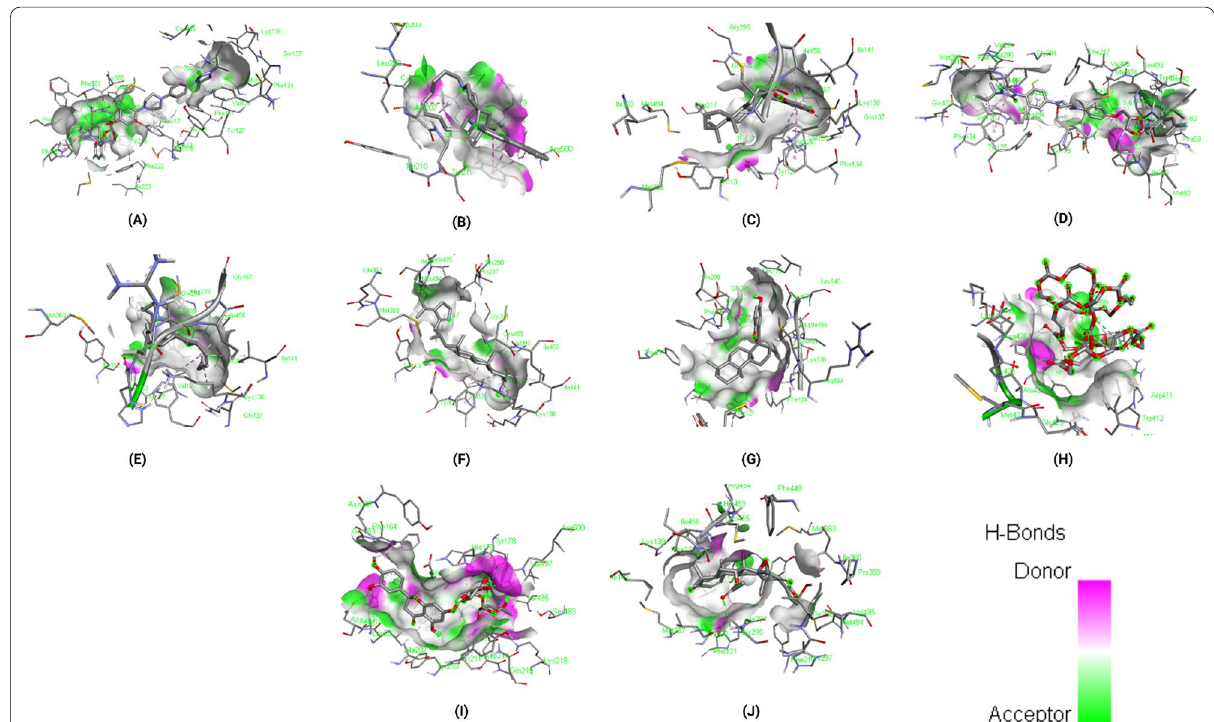
Fig. 7 3D visualisation of docking analysis of Lanosterol 14 alpha-demethylase binding with pramiconazole ( a ), 12,28-oxamanzamine A ( b ), fascioquinol D ( c ), saperconazole ( d ), nakadomarin A ( e ), plakinamine A ( f ), fascioquinol C ( g ), parsiguine ( h ), hesperidin ( i ), epoxyazadiradione ( j